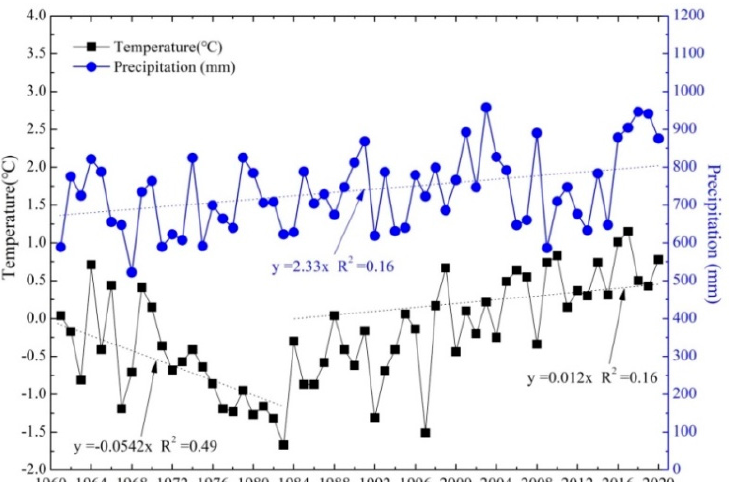
Figure 4. The changes of annual air temperature and precipitation of Jiali Station during 1961–2020. Considering the altitude difference between Jiali meteorological station and JGL (4488.80 m and 4450.0 m, respectively) and the influence of mountainous terrain, the precipitation near the JGL may be more, and temperature will be lower, but the overall feature is still the same period of rain and heat. Glacial lake outburst is easily caused by intense warming and extreme precipitation [13]. According to the monthly temperature and precipitation data of Jiali Meteorological Station in June in 2020, the average monthly temperature in June was 8.28 ◦ C, much higher than the multi-year average of 7.57 ◦ C from 1961 to 2020. High temperatures increase the probability of avalanches, ice avalanches, and landslides, and accelerate glacier melt, which in turn increases the amount of water (ice) bodies flowing into the JGL (Figure 2). At the same time, the precipitation (240 mm) in June was far higher than the mean value of 146 mm from 1961 to 2020. Especially, there was a continuous precipitation process from May 21 to June 24 and the precipitation was as high as 224 mm (Figure 5). It can be said that the high temperature and precipitation process in June before the outburst were the main reasons for the